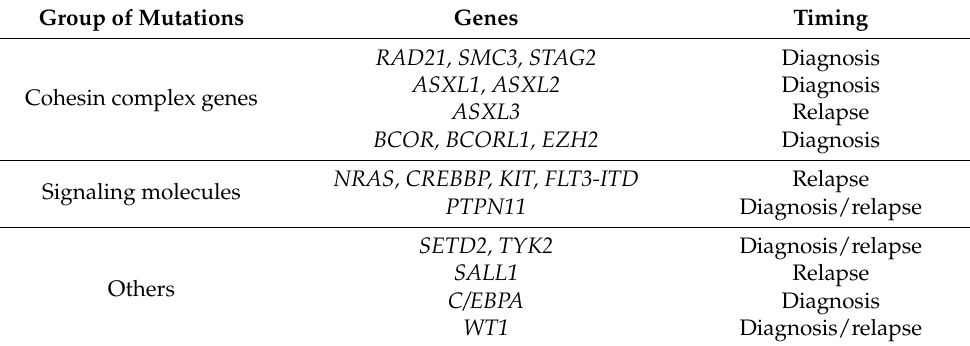
Table 1. List of the main mutated genes, classified in three major groups, with the relative prominent occurrence in terms of timing (mainly at diagnosis and/or